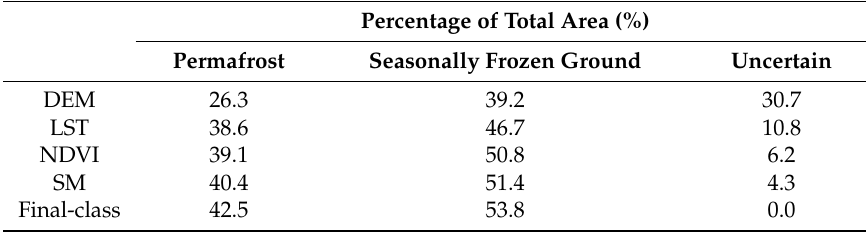
Table 3. The area ratio of the different frozen soil types over the Qinghai Tibet Plateau.